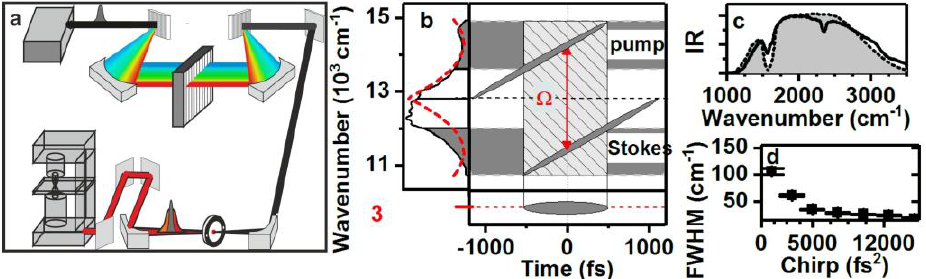
Fig. 1. (a ) Combined setup for infrared and CARS micro spectroscopy. (b) Time frequency map of the spectral focusing concept. (c) Measured (solid line) and simulated (grey background) infrared spectra (d) Spectral infrared line width, displayed as the FWHM of the Gaussian response